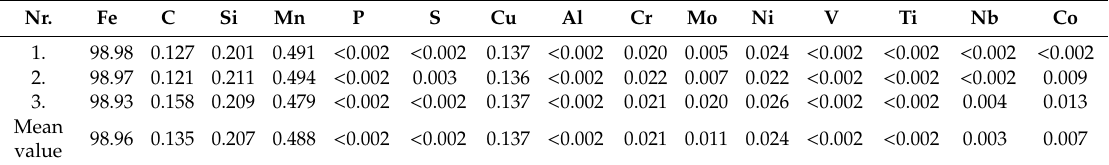
Figure 5. Test specimens: ( a ) for Brinell chemical composition and hardness measuring points and ( b ) for the impact test. Table 2. Chemical composition of the analysed material (%).